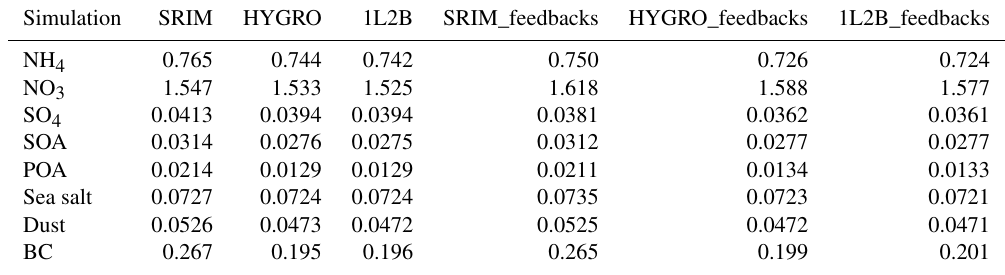
Table 3. Temporally and spatially averaged wet deposition fluxes normalized by temporally and spatially averaged surface concentrations for each simulation. All units are molcm − 2 d − 1 divided by µgkg − 1